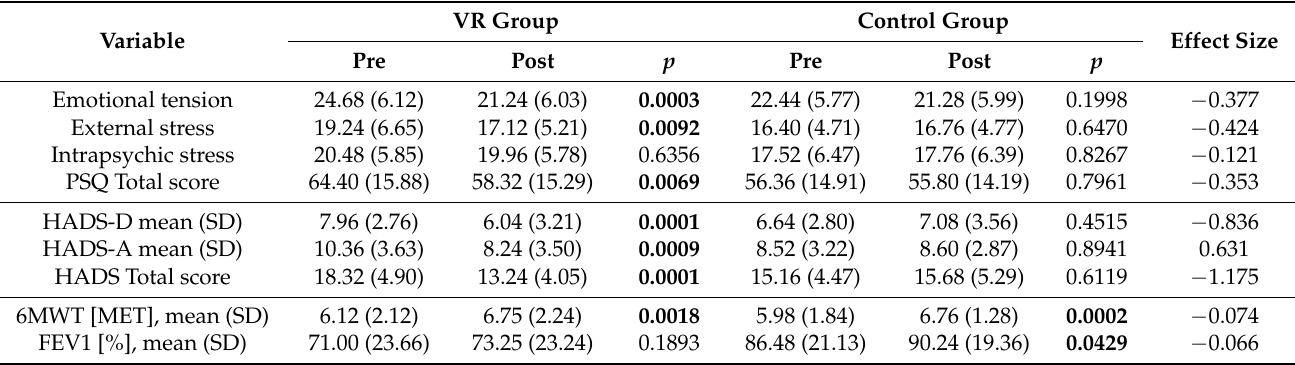
Table 2. Analysis of the stress, anxiety, depression, and functional capacity assessment within the examined groups expressed as mean (SD).